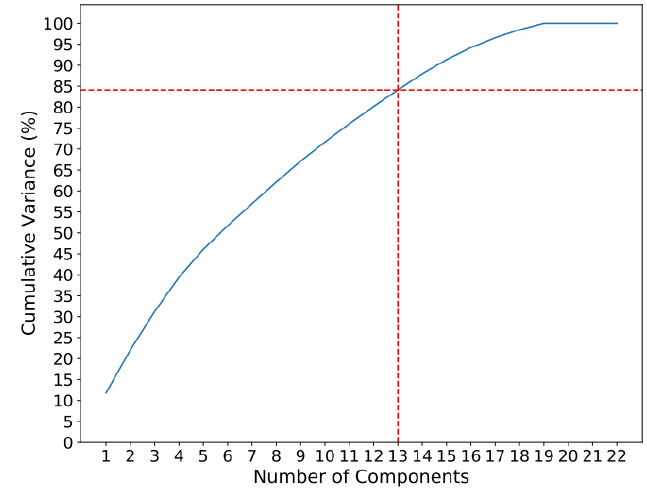
Figure 2. Visualization of cumulative variance.